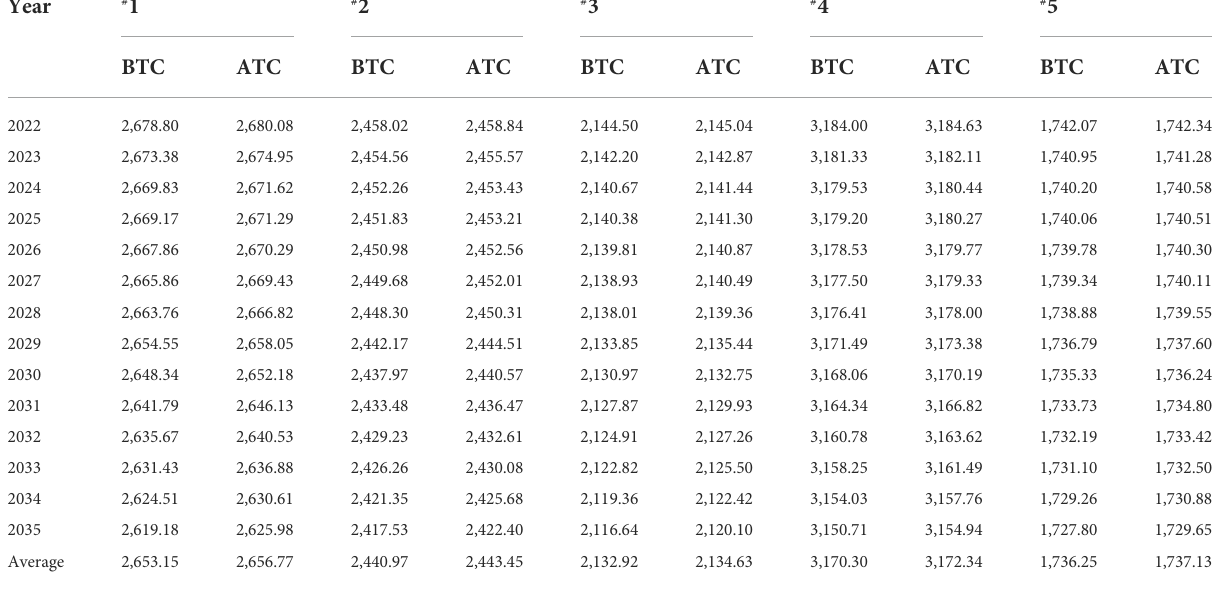
TABLE 7 Annual electricity demand for the fi ve selected households from 2022 – 2035